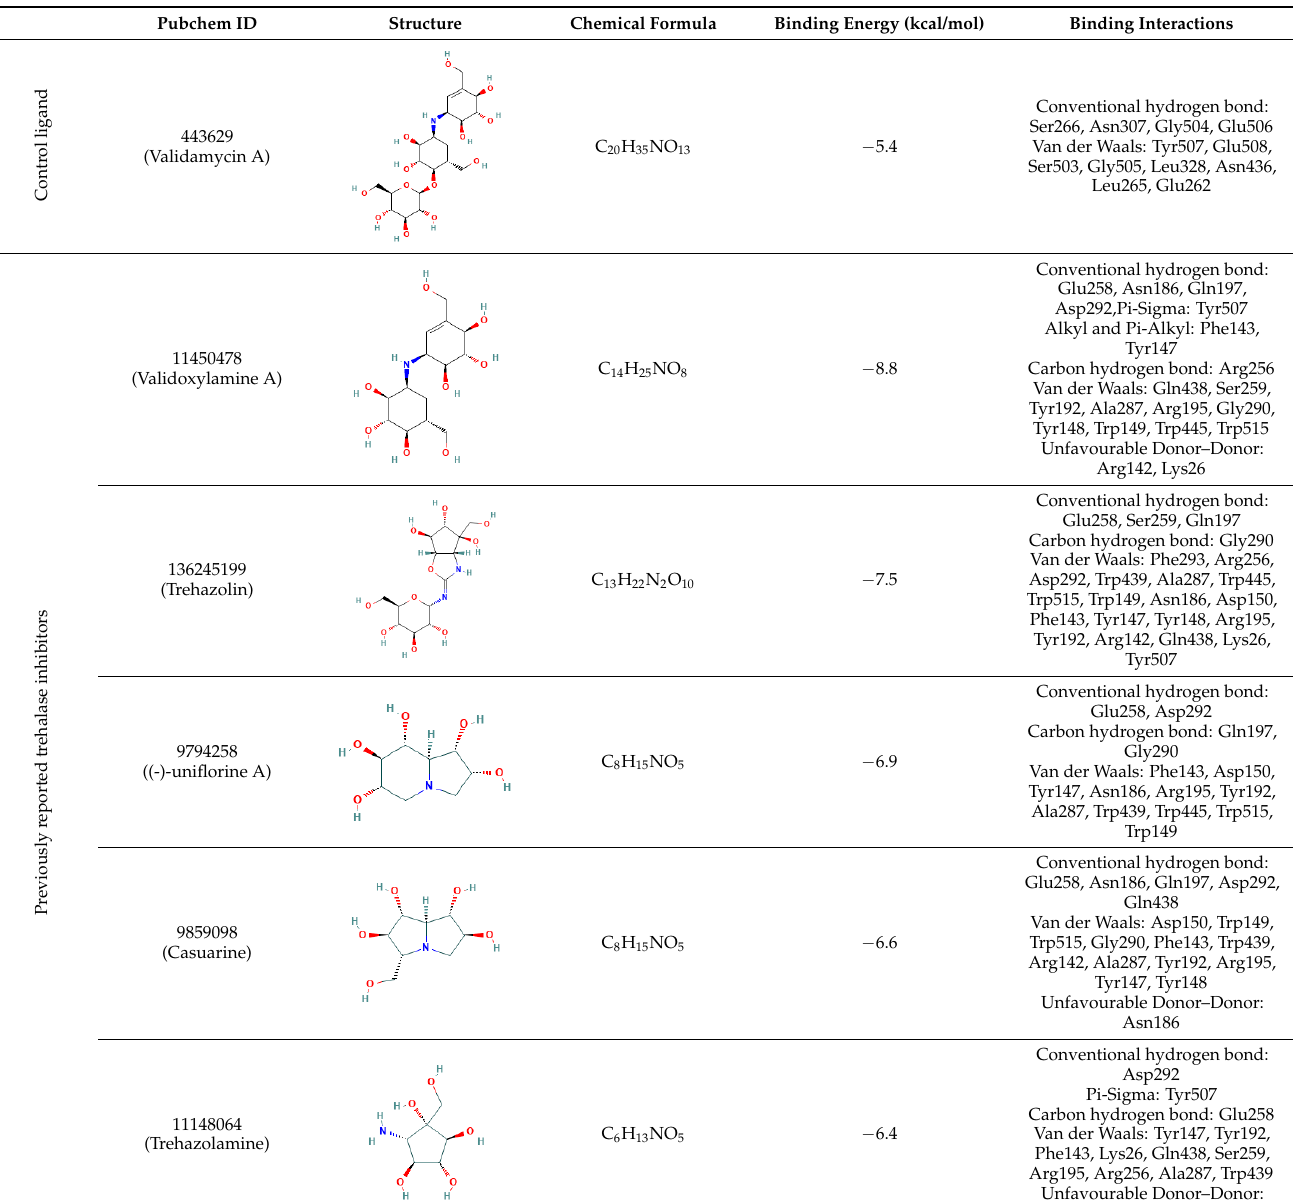
Table 3. Structure, chemical formula, binding energies, and binding interactions of Ag Tre with the control ligand, previously reported trehalase inhibitors, and the top 9 hits from the virtual screening